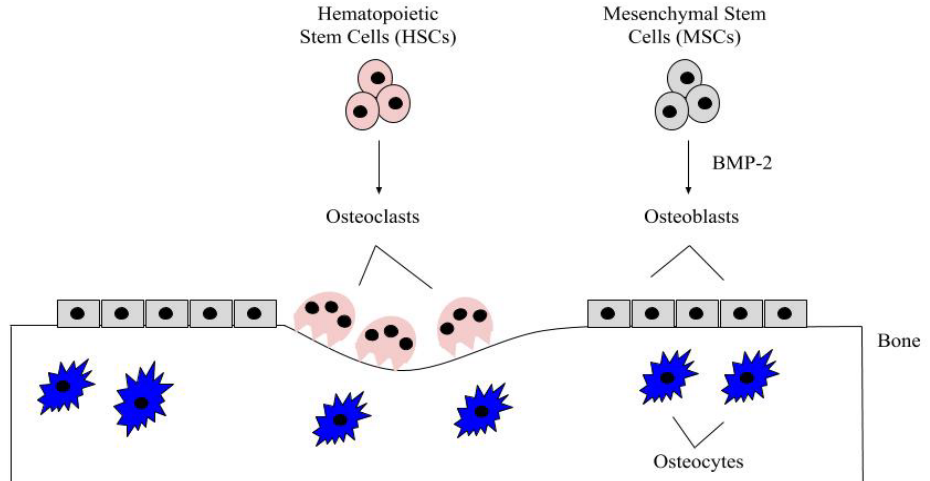
Figure 1. The bone microenvironment. Healthy bone function and renewal is controlled by the activity of osteoblasts and osteoclasts. Osteoblasts derive from MSCs, which commit to the osteoblast lineage after exposure to BMP-2. BMP-2 is secreted into the bone matrix or bloodstream by pre-existing osteoblasts, osteocytes, and endothelial cells, where it can bind to bone morphogenetic protein receptors (BMPRs) on MSCs. After MSCs differentiate into osteoblasts, these cells secrete the organic matrix of the bone. Some eventually become embedded within the bone as osteocytes, which provide further structure. HSCs differentiate into osteoclasts after being stimulated with factors, such as RANK-L and NF-kB. The osteoclasts are multinucleated and resorb the bone matrix, releasing contents (i.e., BMP-2 and calcium) to be recycled throughout the body.